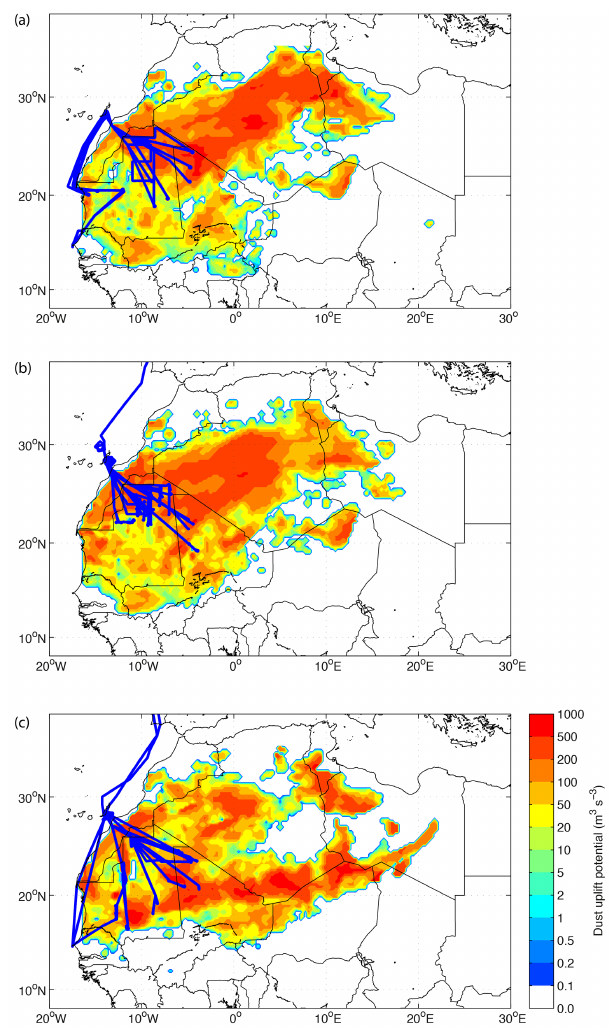
Figure 12. Composite of the dust uplift potential (DUP, shading, m 3 s − 3 ) for the air masses observed by the aircraft lidars during all flights from each campaign (blue lines). Calculations have been performed for tropospheric curtains along the flight tracks, integrat- ing the dust uplift potential for the 3 days preceding each research flight. DUPs are shown for (a) Fennec 2011 Falcon flights; (b) Fen- nec 2011 BAe146 flights; (c) Fennec 2012 BAe146